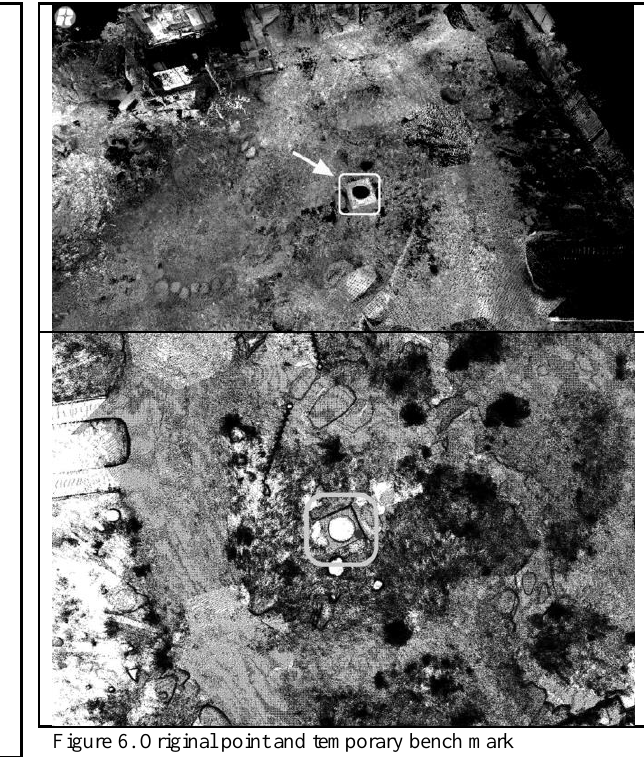
Figure 6. Original point and temporary bench mark